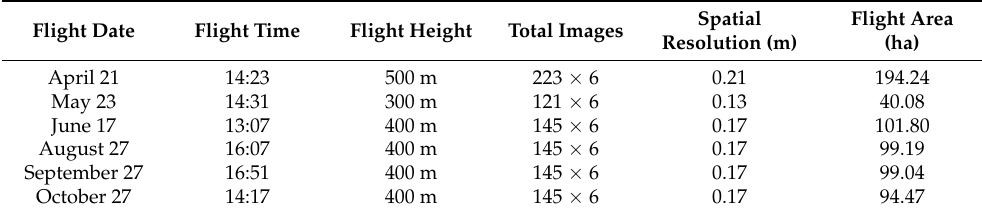
Table 2. Flight parameters and image information from the UAV on different